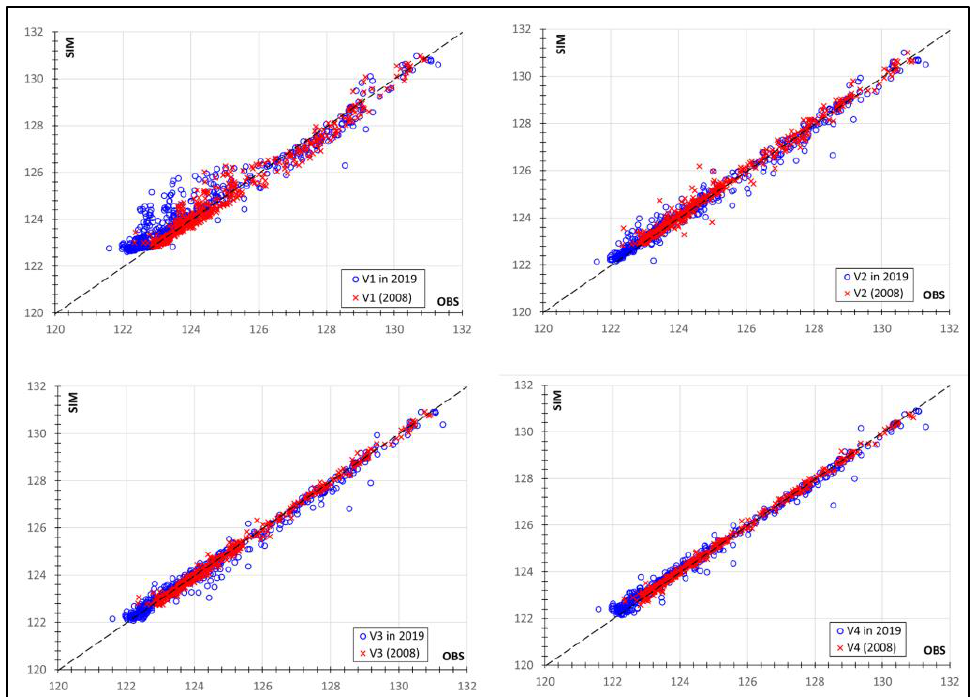
Figure 10. Scatterplots of observed and simulated groundwater heads within individual model variants (V1–V4) after calibration (2008) and within prediction (2019).